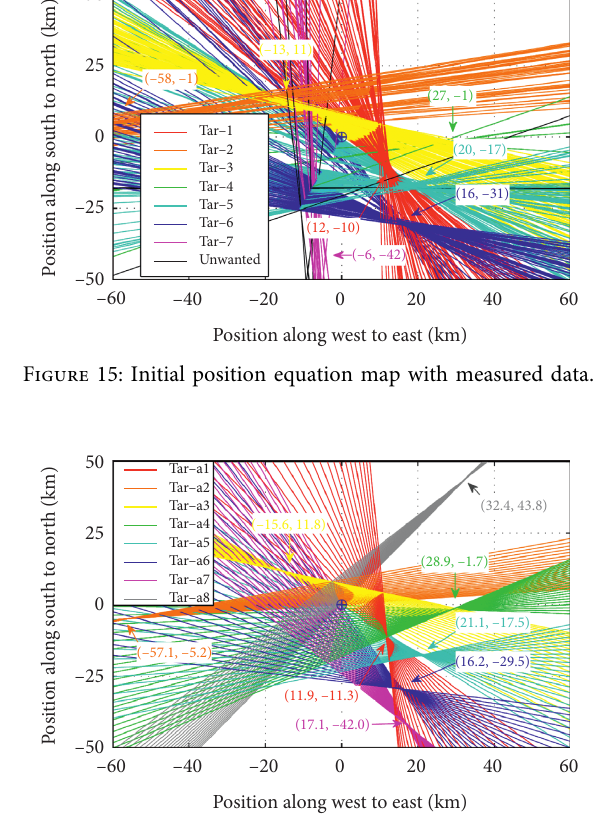
Figure 16: Initial position equation map with ADS-B information.